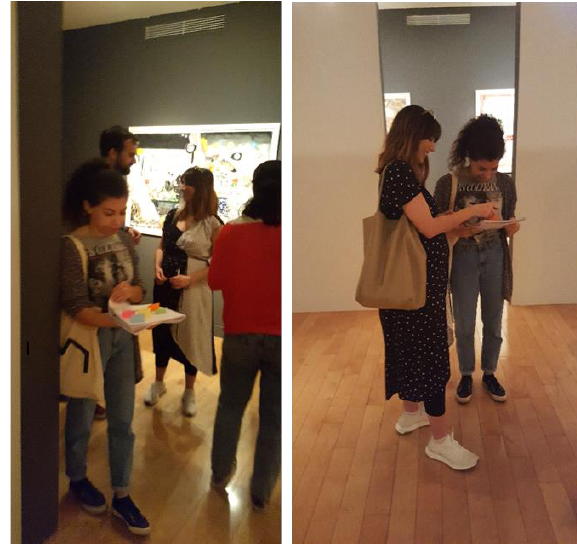
Figure 3. Snapshots from playtesting, showcasing the use of the notebook.